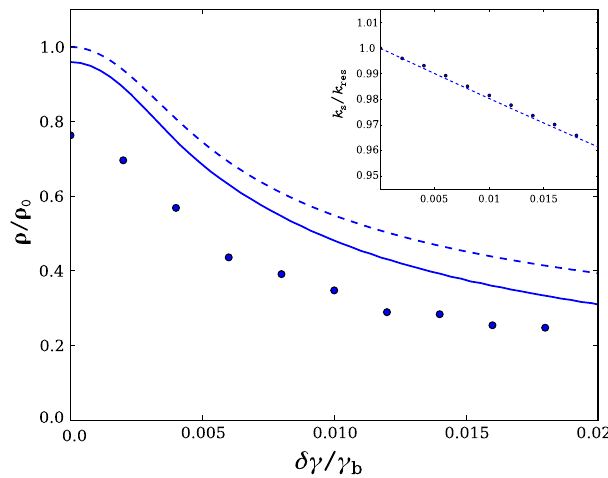
FIG. 7. Dependence of the FEL parameter on the energy spread of the electrons for the analytical (dashed line) and numerical ad hoc (solid line) models (21) and in the PLARES simulations (dots). The inset shows the dependence of the normalized resonant wave number on the energy spread in the simulations (dots) and according to condition (20) (dashed